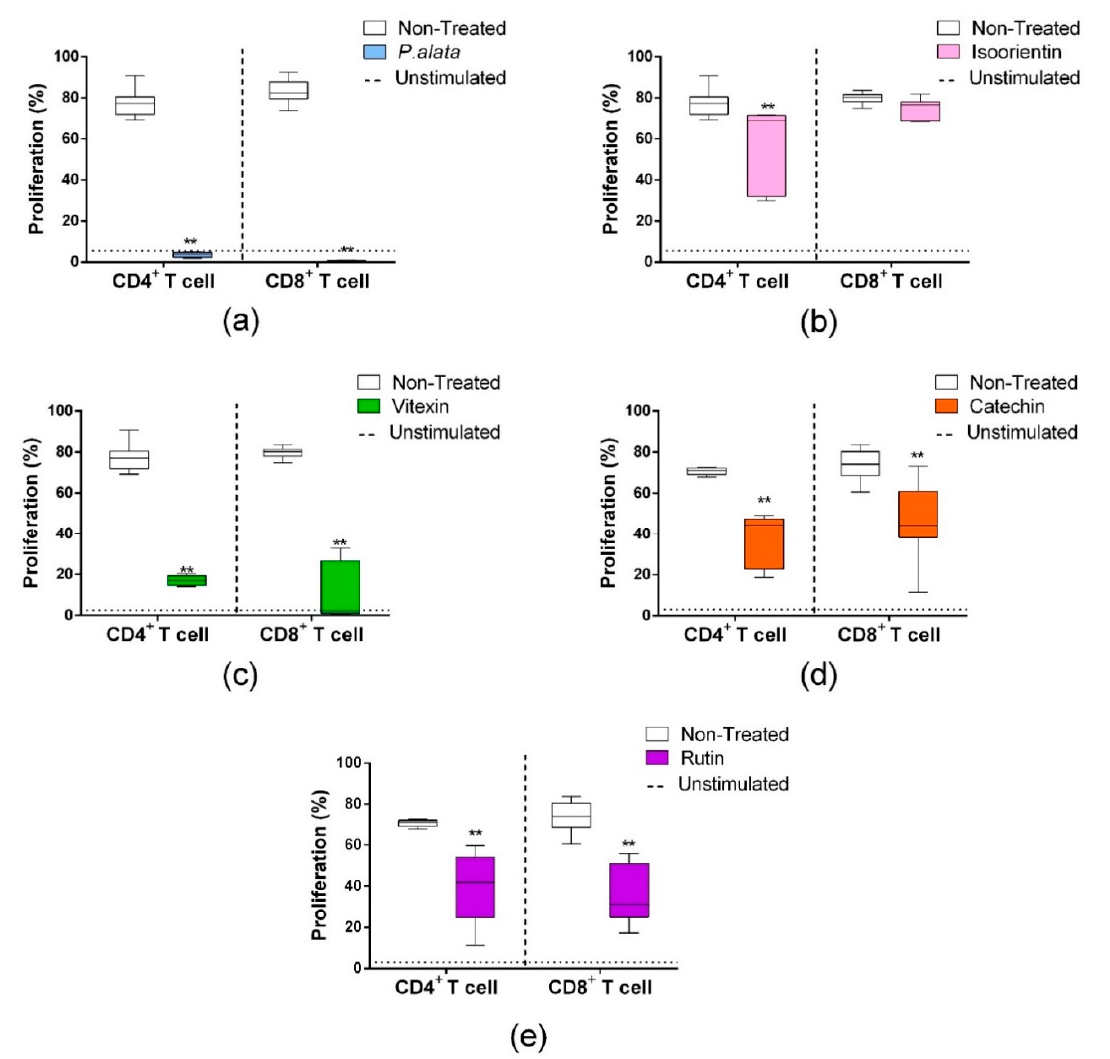
Figure 3. Effects of P. alata extract and polyphenols in the proliferation of CD4 + and CD8 + lymphocyte subsets. The boxplots represent the frequency of CD4 + (left) and CD8 + (right) proliferating T cells (CFSE low population) treated (colored) or non-treated (white) with IC 50 of P. alata extract ( a ) and polyphenols: isoorientin ( b ), vitexin ( c ), catechin ( d ) and rutin ( e ). Dotted lines represent the frequency of proliferating cells of non-stimulated lymphocytes: ** p < 0.0001, compared to the non-treated group; n = 6 with triplicate cell